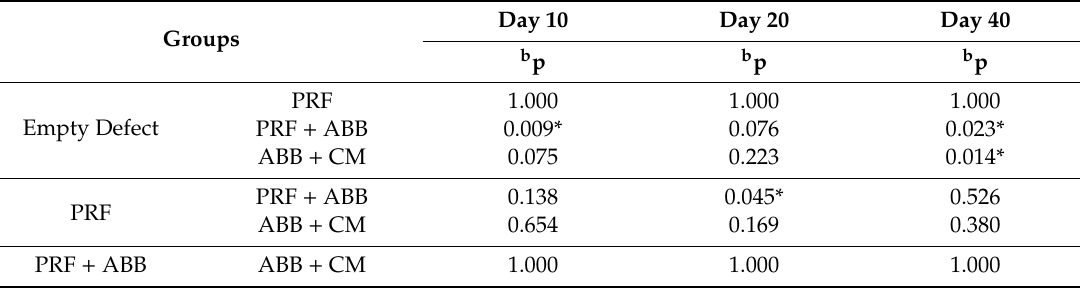
Table 2. Pairwise comparison of